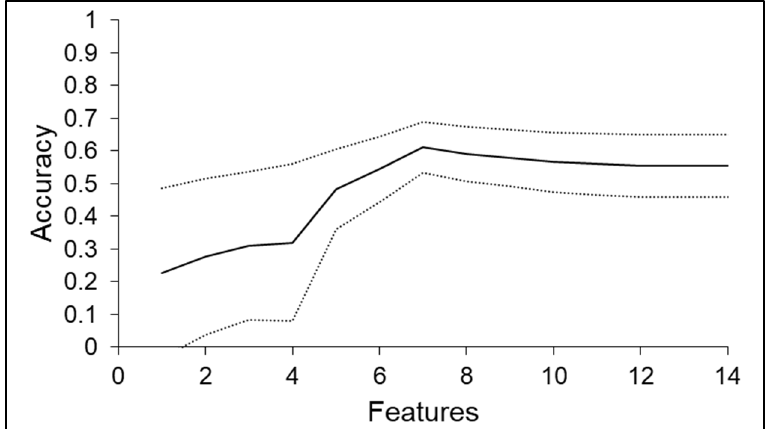
Figure 9. Relationship between cross validation accuracy score and total number of features present in the intermediate ML-based model. The black line corresponds to the mean CV score, whereas the dashed lines represent an interval of plus or minus one standard deviation.